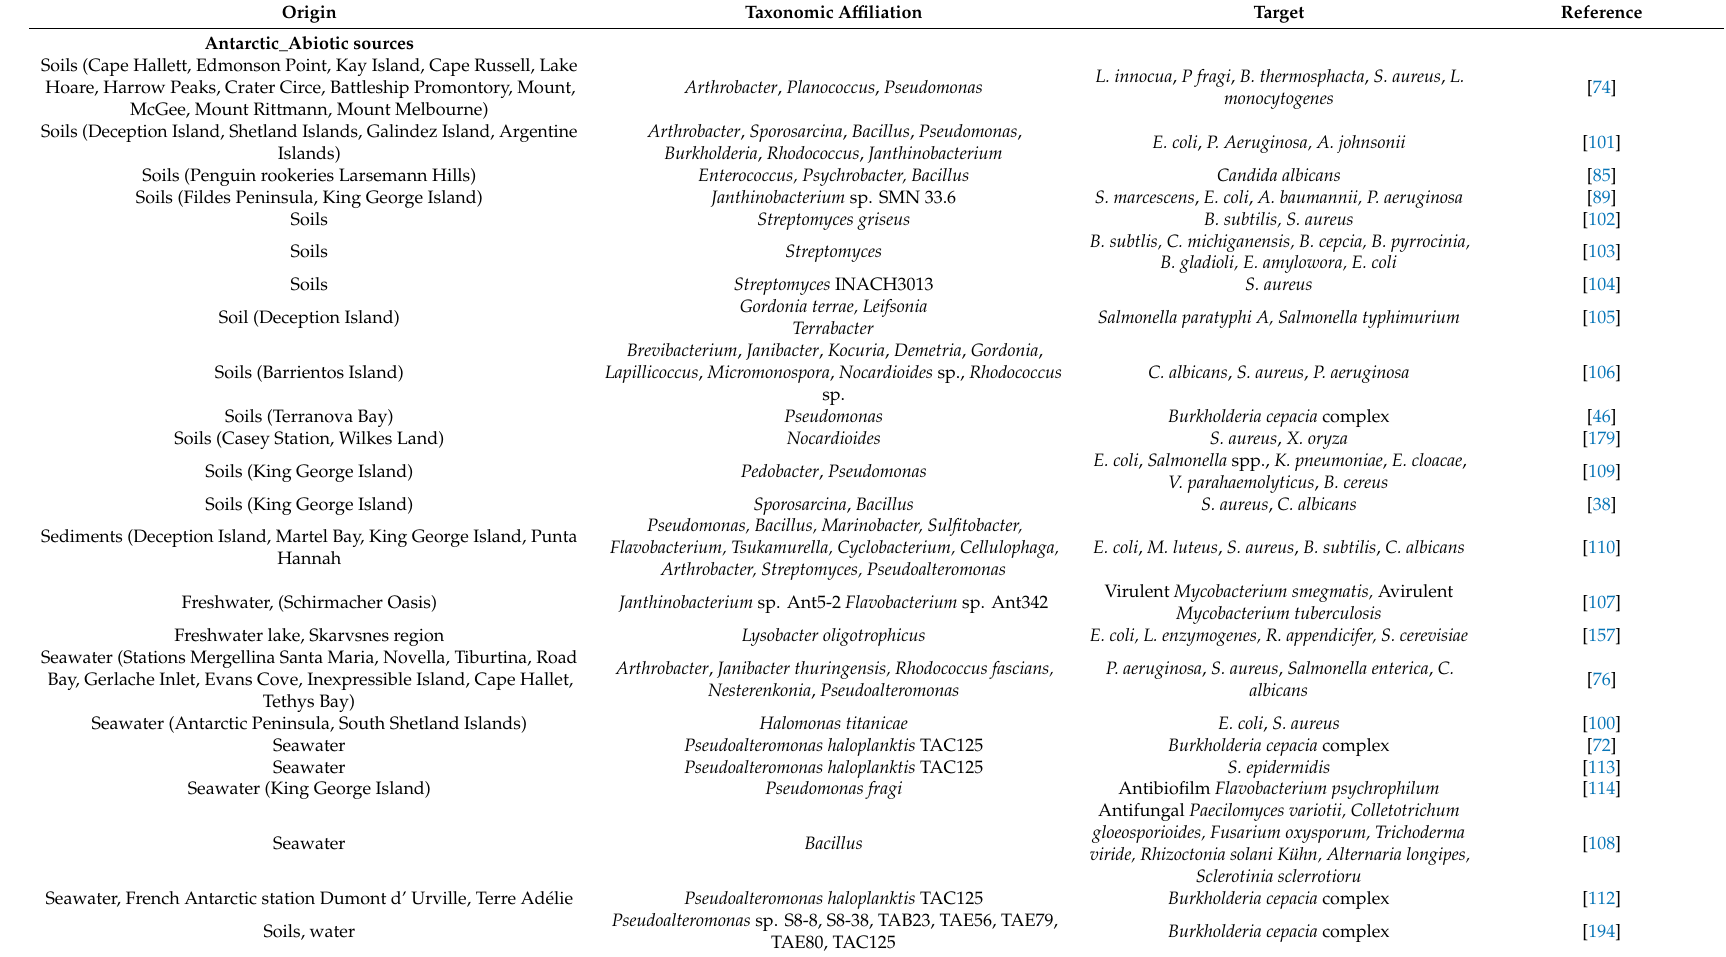
Table 4. List of cold adapted Abs bacterial producers considered for the review